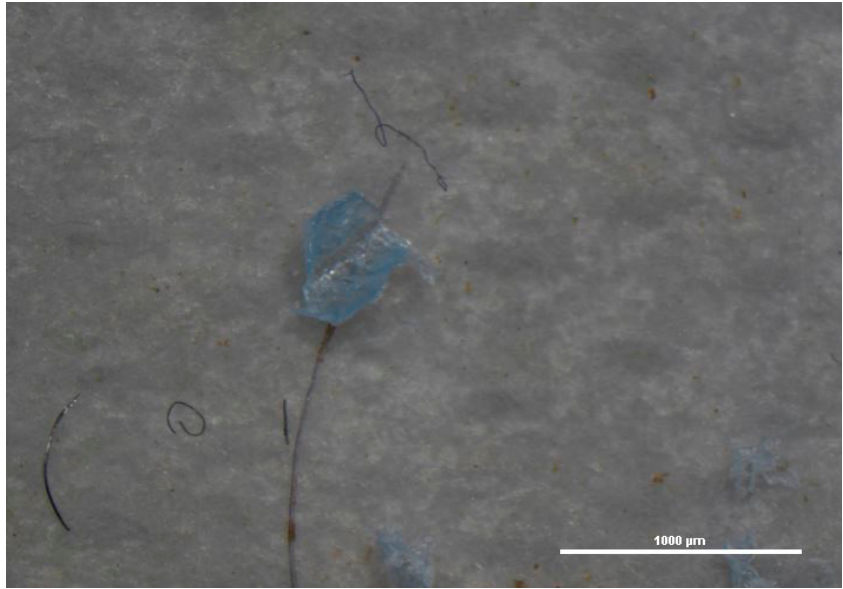
Figure 1. Irregular blue fragment of polypropylene used as reference material.